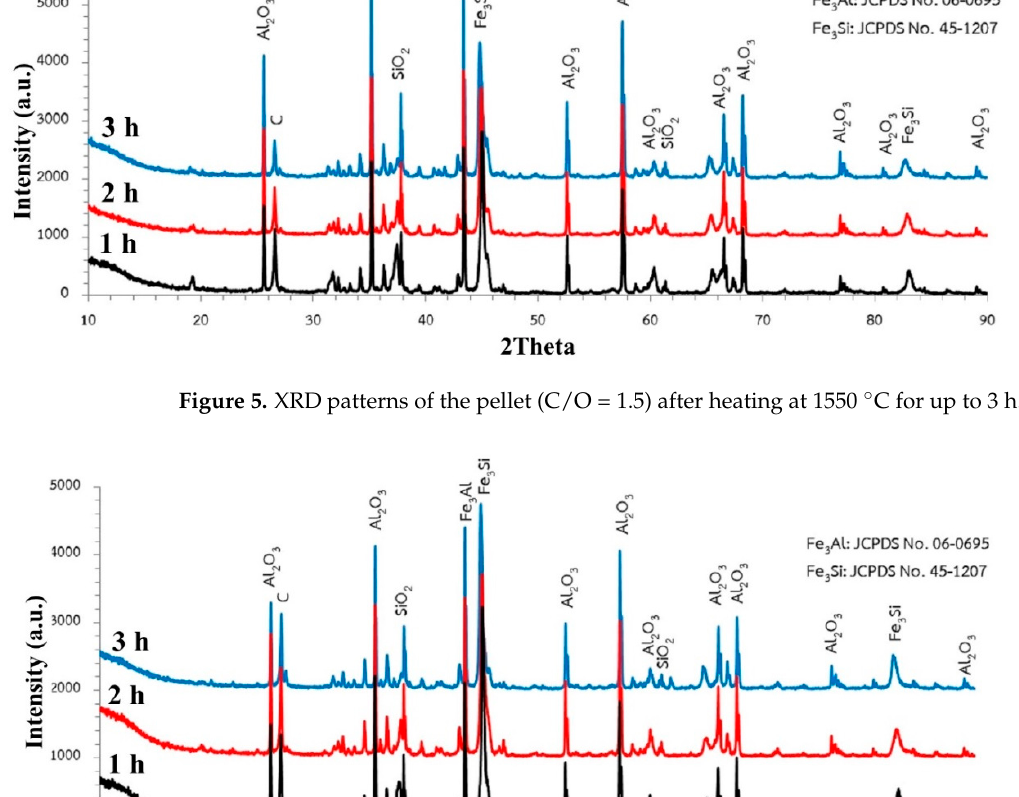
The overall carbothermic reduction of Al 2 O 3 as shown in Equation (7), is known to occur at the temperature of over 2200 ◦ C at 1 atm [34]. This reaction could produce Al 2 O gas, Al vapor, and CO gas via the reaction pathway, Equations (8) and (9). However, the reduction reaction of Al 2 O 3 by solid carbon had also been reported to start at a